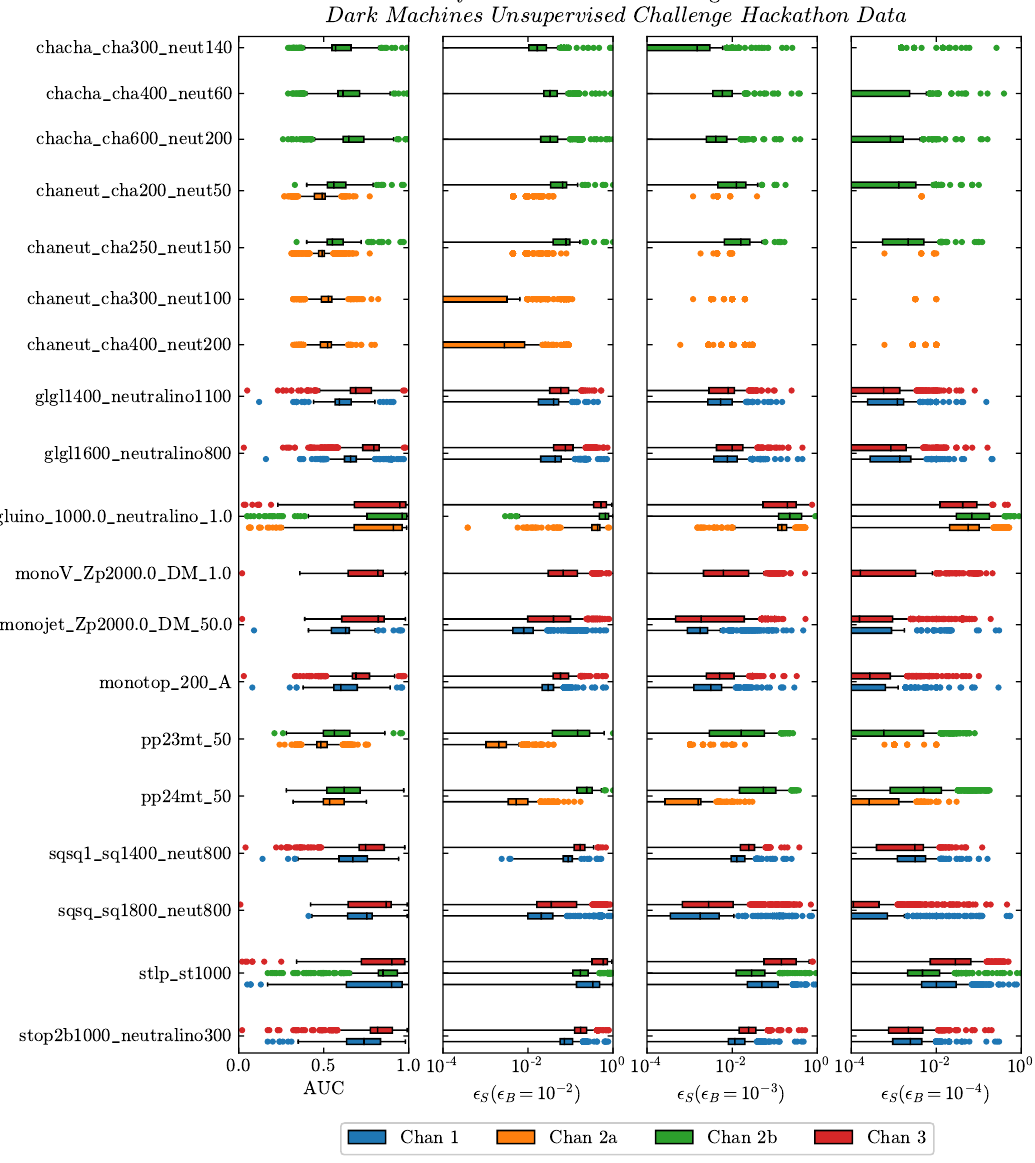
Figure 11: Box plots for each of the physics signals in the hackathon dataset. These summarize the span of results for the many anomaly detection models trained on background only samples. Channel 2a has the tightest pre-selection cuts, and there- fore less data, which leads to the signals looking less